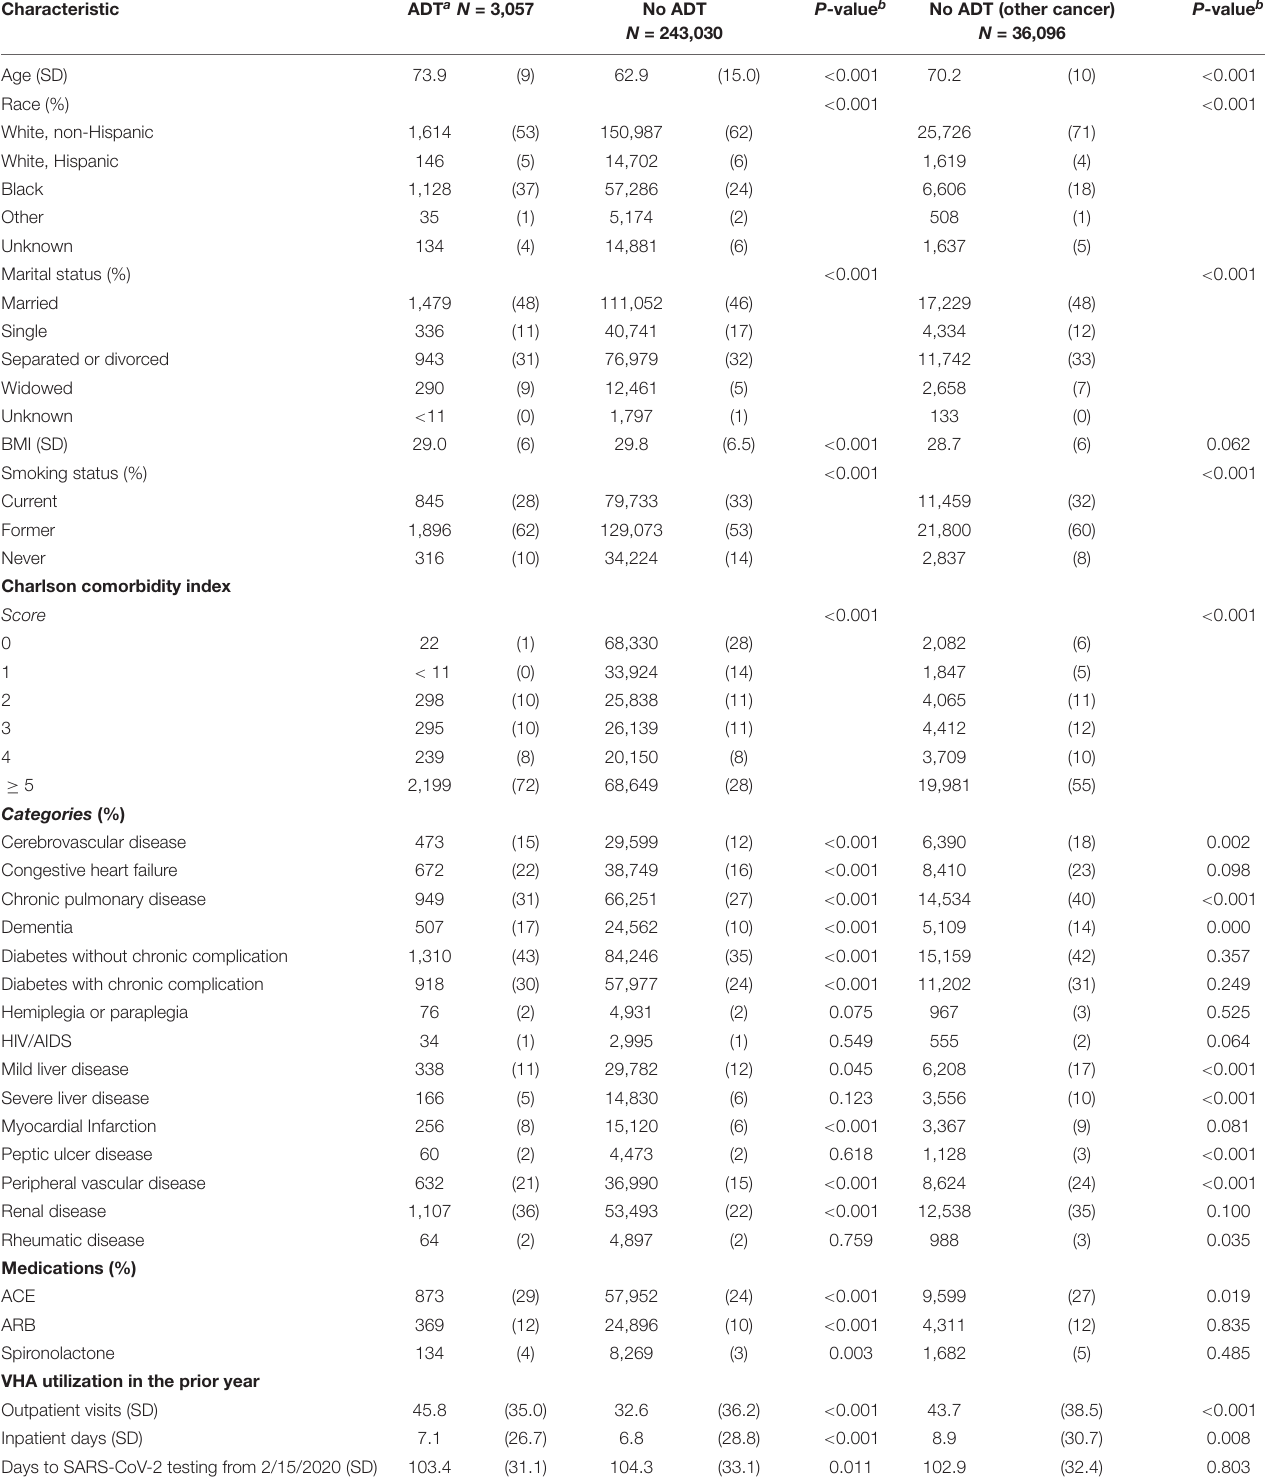
TABLE 1 | Baseline characteristics of patients tested for SARS-CoV-2.